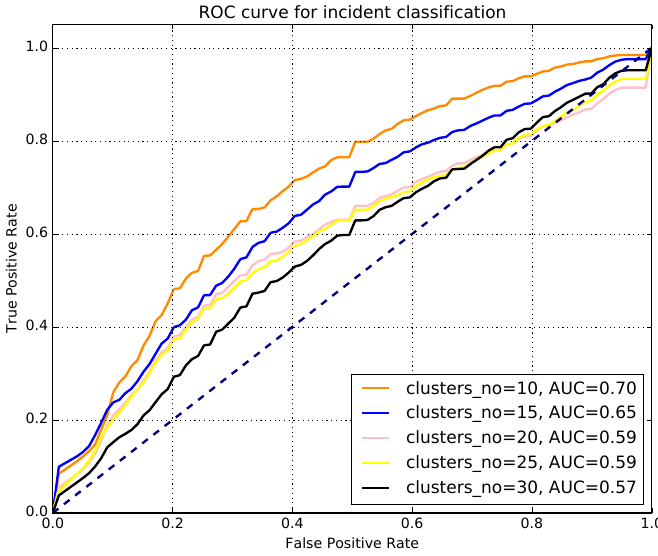
Figure 3. Classification for ’incident’ detection based on HRV parameters, performed on 5 different sets of R-R epochs delineated via accelerometer data using 5 different clustering parameters ( k = 10,15,20,25 and